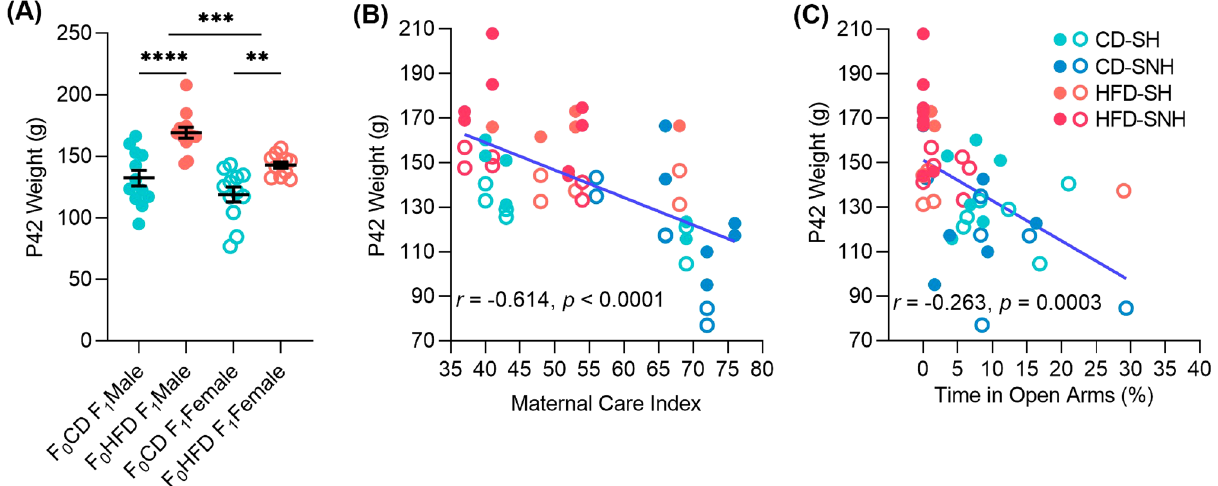
Figure 2. F 1 offspring weight is associated with paternal dietary treatment, maternal behaviors, and anxiety- like behaviors in the EPM. ( A ) F 1 offspring weights are dependent on F0 paternal dietary treatment with HFD. Data shown represent means + standard errors for each group. ( B ) Pearson’s correlation of F 0 maternal behaviors (scored for observational periods of 72 min, 5 times per day for 7 days from PD1 to 7 as a maternal care index of licking, grooming, and arched-back nursing) with adult F 1 offspring weights taken at the time of sacrifice. Points represent data collected from individual rats (blue = F 1 offspring of control diet (CD) sires, orange = F 1 offspring of high-fat diet (HFD) sires). ( C ) Pearson’s correlation of time spent in open arms of the elevated plus maze (EPM) against adult F 1 offspring weights taken at the time of sacrifice. Points represent data collected from individual rats (blue = F 1 offspring of control diet (CD) sires, orange = F 1 offspring of high-fat diet (HFD) sires). Statistical significance was evaluated using a pairwise t-test within F 1 sexes. ** p < 0.01, **** p < 0.0001. CD control diet, HFD high-fat